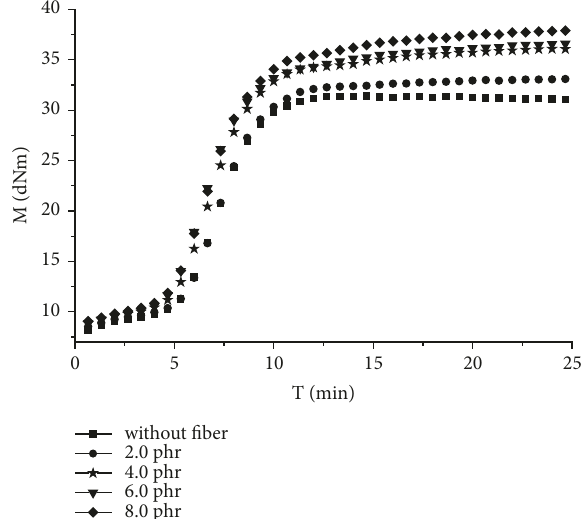
Figure 5: Effects of MNSF-2 content on cure characteristics of tread compounds.